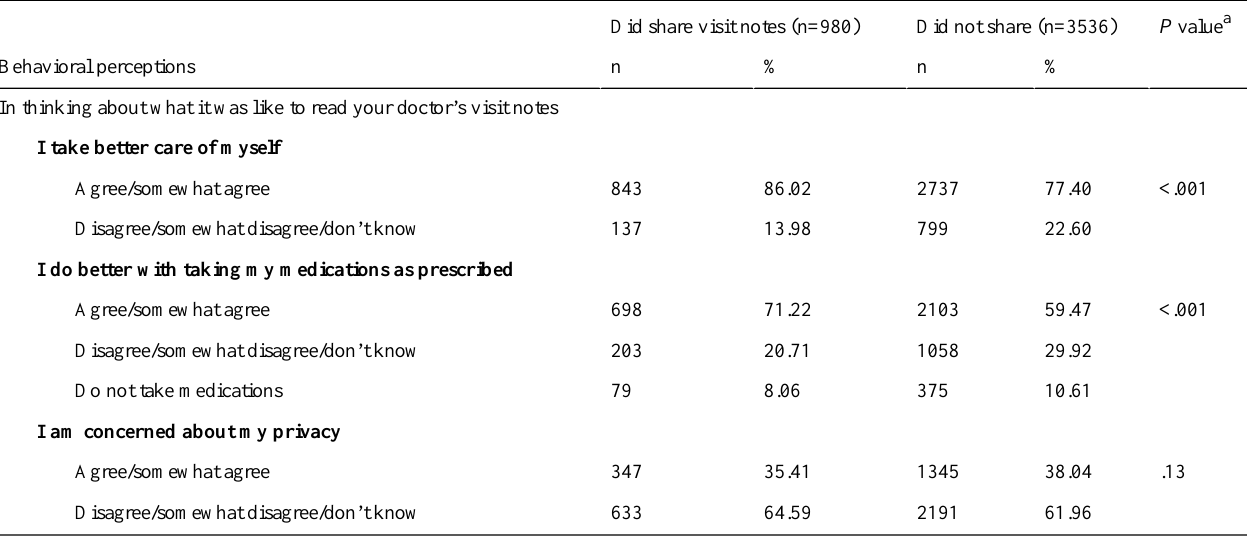
Table 3. Behavioral perceptions of patients who reported sharing their visit notes with someone else during the study (N=4516).